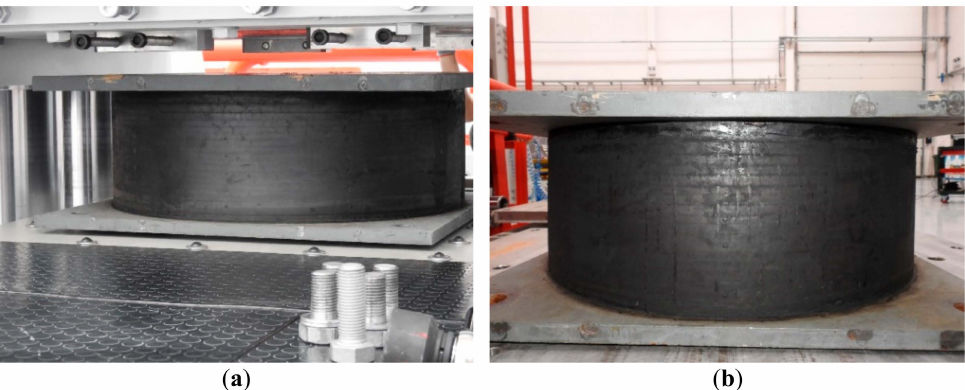
Figure 5. Physical condition of the LRB ( a ) before the initial loading and ( b ) after the final loading